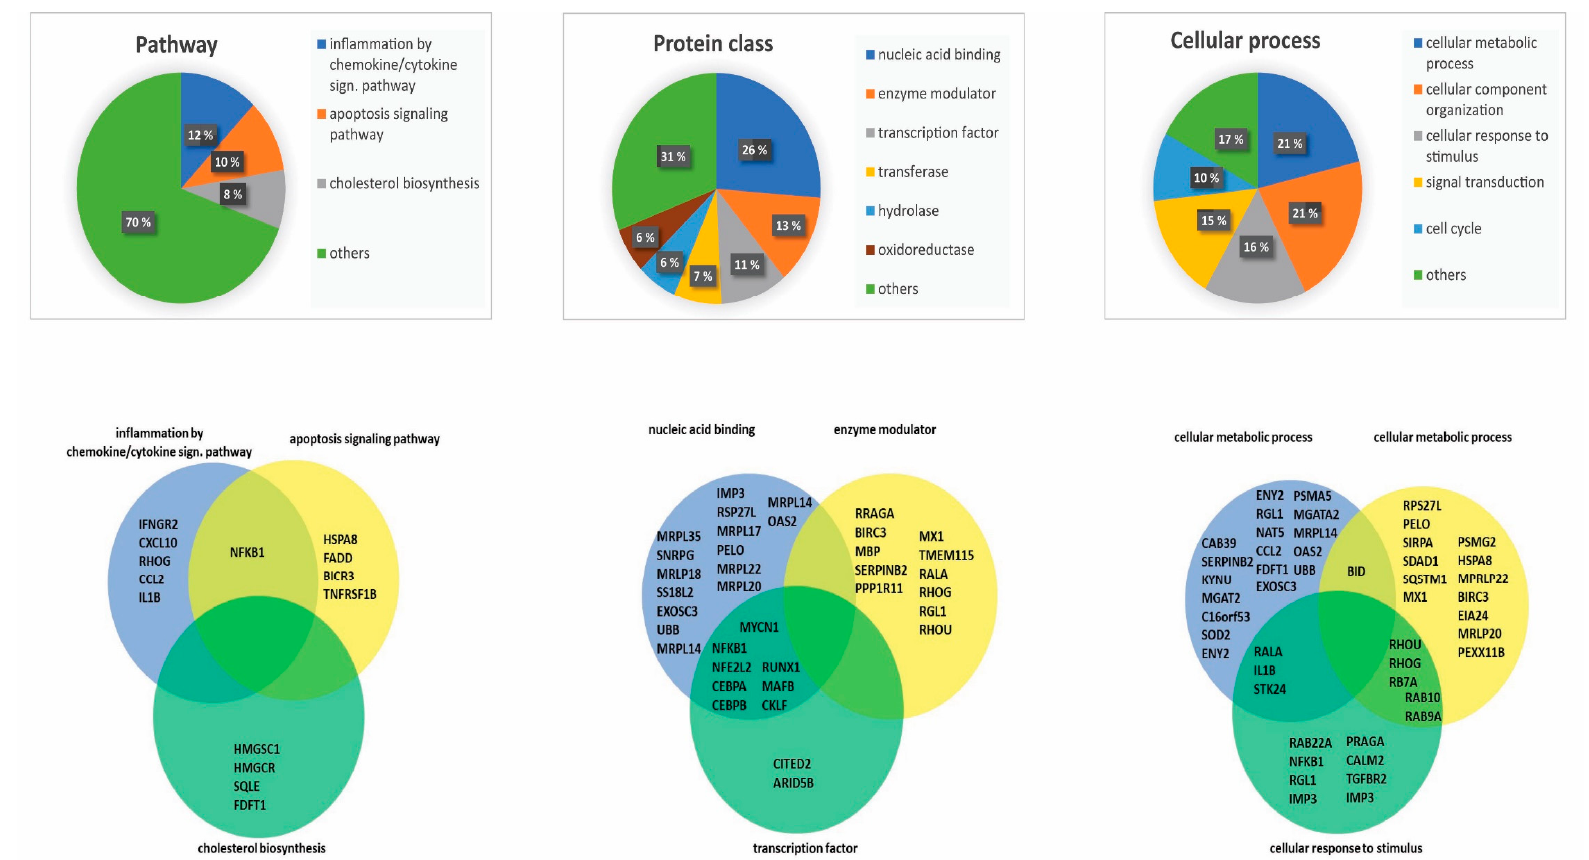
Figure 3. Classification of downregulated genes by BMS-345541 inhibition: We classified the 183 genes downregulated by nuclear factor- κ B (NF- κ B) inhibition according to their biological function by using the PANTHER database. As indicated at the top of the figure, we selected the three major terms pathway ( left ), protein class ( middle ), and cellular process ( right ) for detailed analyses. We were then able to identify major subgroups within each of these three main terms (upper part of the figure), as indicated by the corresponding diagrams in the lower part of the figure. For each of the three main terms (i.e., pathway / protein class / cellular process), we then selected the three largest subgroups of downregulated genes (see the lower part). For each main term, the three selected subgroups / terms are presented as partly overlapping circles, and the individual genes included in the various subgroups are